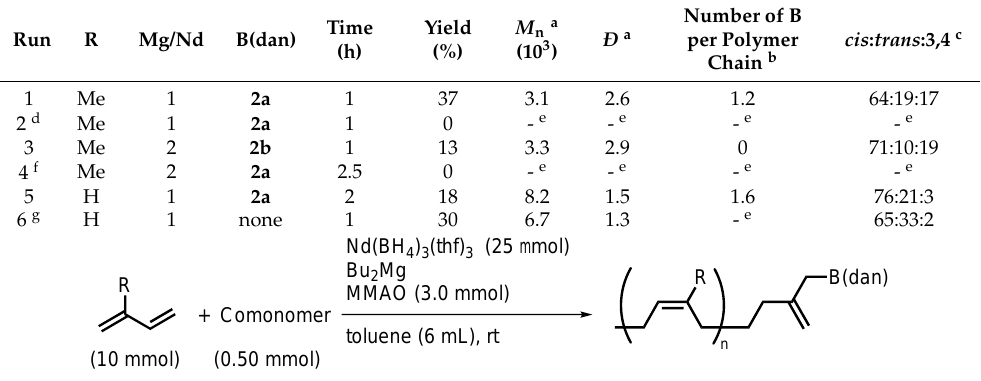
Table 1. Chain-end functionalization of polydienes with boronic acid diamide monomers 2a and 2b . Run R